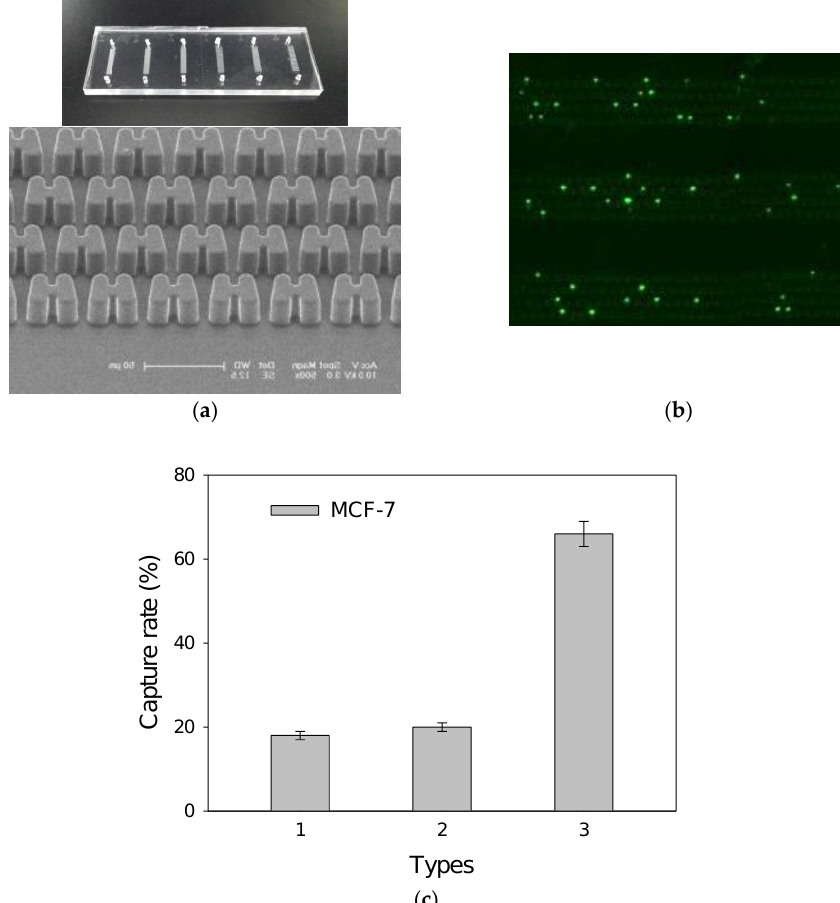
Figure 3. Photographs of glass-PDMS microfluidic chip, and the magnified SEM image of a cross- arranged microstructure (type 3) ( a ), fluorescence photograph of the captured CTCs (MCF-7) ( b ), and the capturing rate according to three different geometries ( c